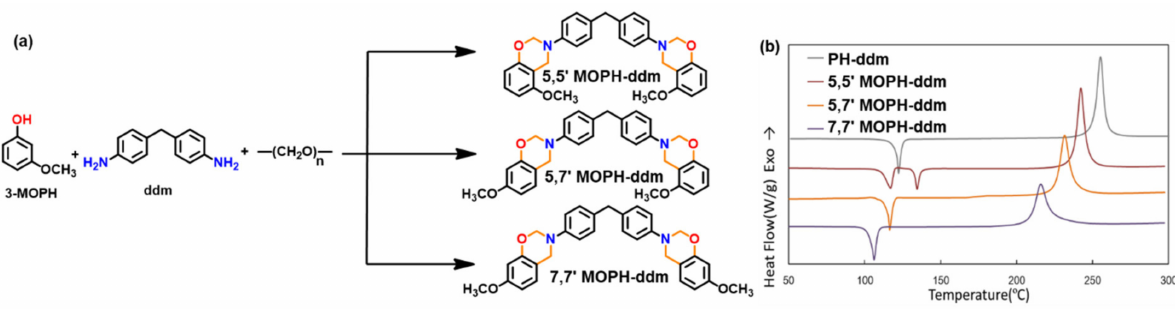
Figure 12. ( a ) Synthesis of 3-methoxyphenol and ddm based benzoxazine isomers and ( b ) DSC thermograms of MOPH-ddm isomers showing only well-defined single exotherm for each isomer [139]. Copyright 2020. Reproduced with permission from Royal Society of Chemistry, London,